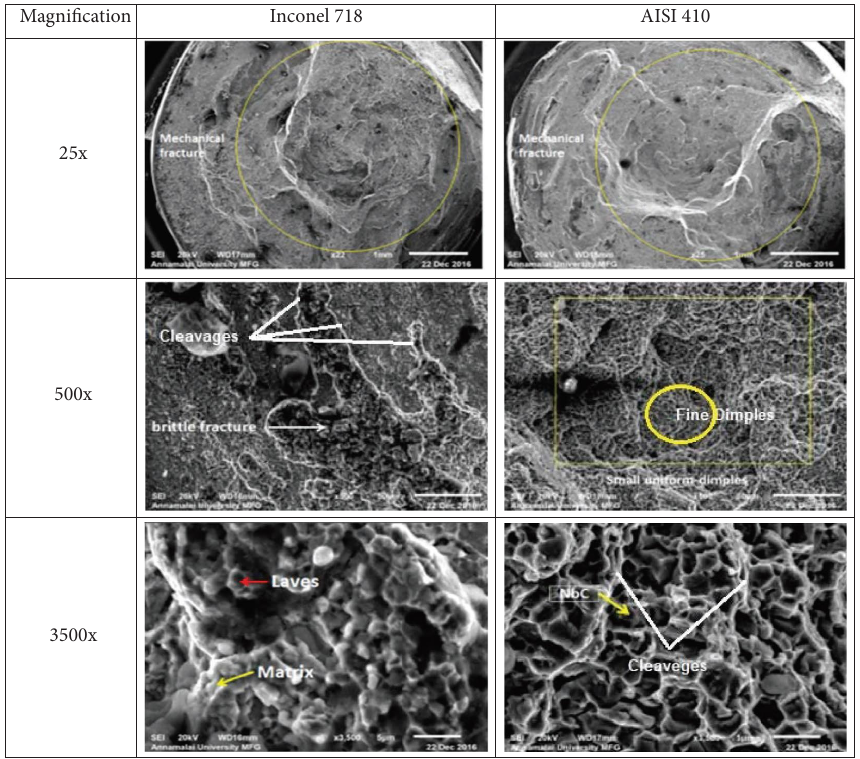
Figure 11: Fractography of tensile-tested samples of dissimilar friction welded joints. Position Zones Component Graph Results Fully deformed zone of Inconel